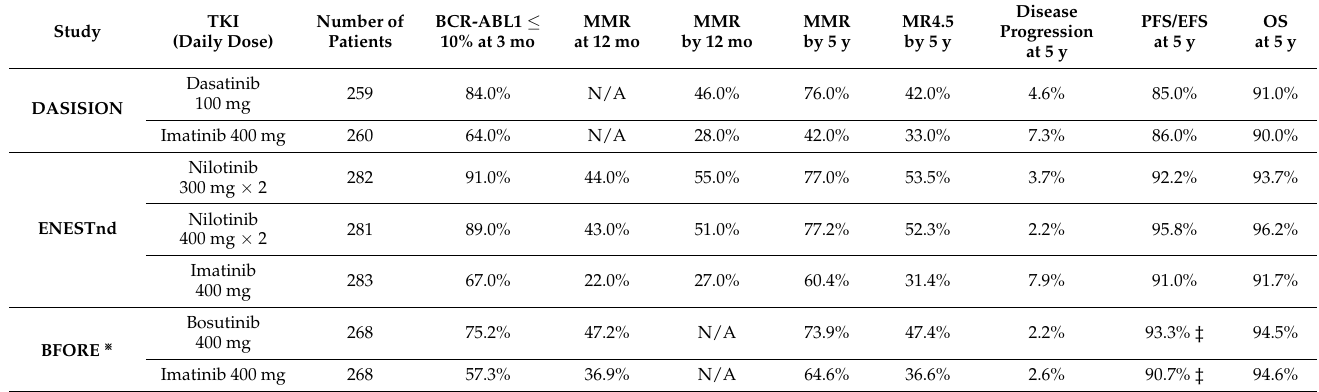
Table 1. Clinical outcomes of approved TKIs for first-line treatment of newly diagnosed CML-CP in phase III trials: comparison between imatinib and